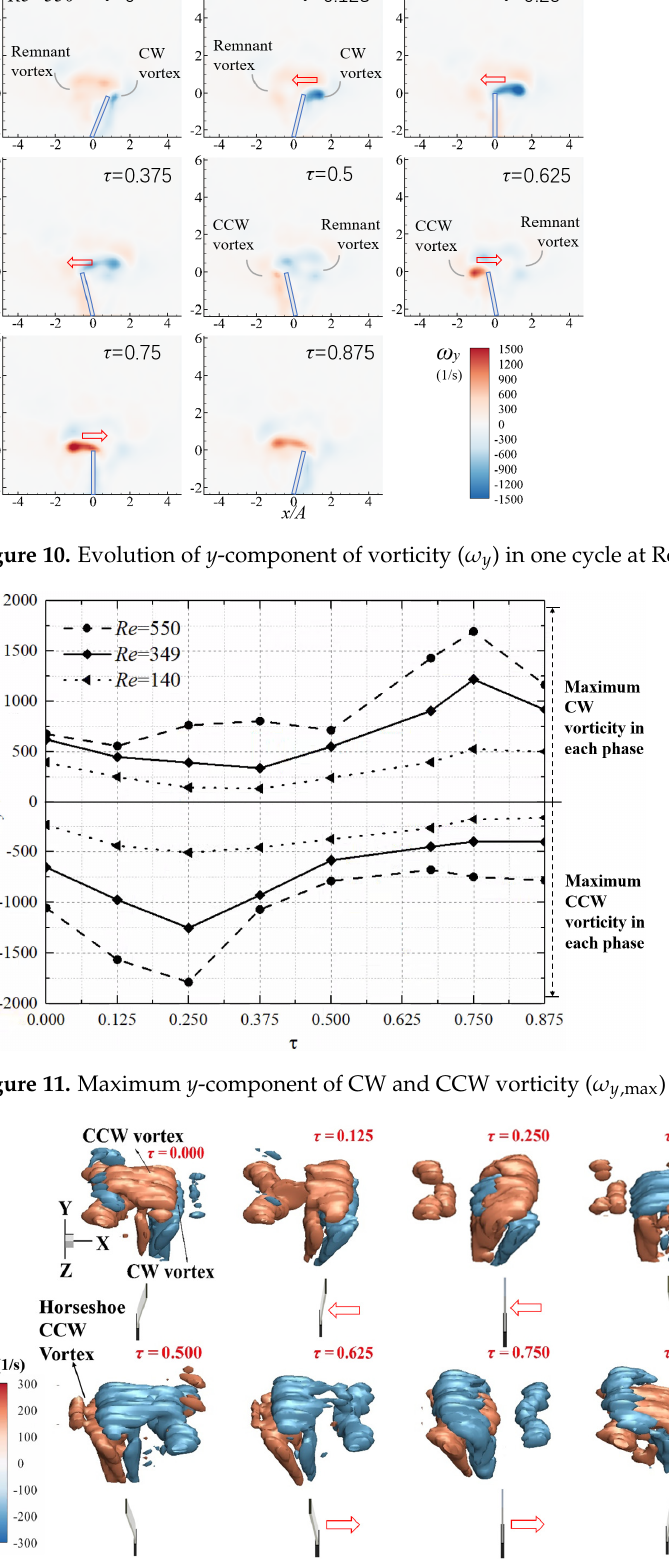
Figure 12. Temporal evolution of vortex in an oscillation period in 3D ( Re = 550). At two side edges of the blade, there is also a vortex generated. Together with the vortex at the trailing edge, a horseshoe structure is formed, which has been shown in Fig- ure 13a. The CW vortex continues to develop in the later phases and the head of the horse- shoe vortex is elongated in x -direction. At phase τ = 0.5, when the blade changes the di- rection of movement, two distinct vortex rolls are observed. This demonstrates the shed- ding of the CW vortex. The vortex shed from the blade tip then develops into a hairpin structure (see Figure 13b) and gradually diffuses in the flow field. The part still connected to the blade tip eventually detaches as the blade moves towards the right, then it propa- gates and dissipates as traveling in streamwise direction. The formation of the horseshoe vortex and hairpin vortex is consistent with previous studies reported in [15,16]. Figure 13. Typical flow structures generated by PZT fan: ( a ) a CW horseshoe vortex at τ = 0.25, ( b ) a hairpin vortex at τ = 0.375. Figure 14 illustrates the vortex structure generated by the PZT fan blade at different Reynolds numbers. At Reynolds number Re = 349, the generation, spreading, splitting, propagation and diffusion processes are basically the same when comparing to the case of Re = 550. The vortex shedding can also be observed. However, due to the lower vorticity strength, the iso-surface structure reduces in scale. As the Reynolds number further de- creases to Re = 140, the two legs of the horseshoe vortex generated at the side edges are no longer observed due to the lower vortex core strength. Besides, the vortex at the trailing edge dies out soon after it was generated. No vortex shedding was observed at this Reyn- olds number.